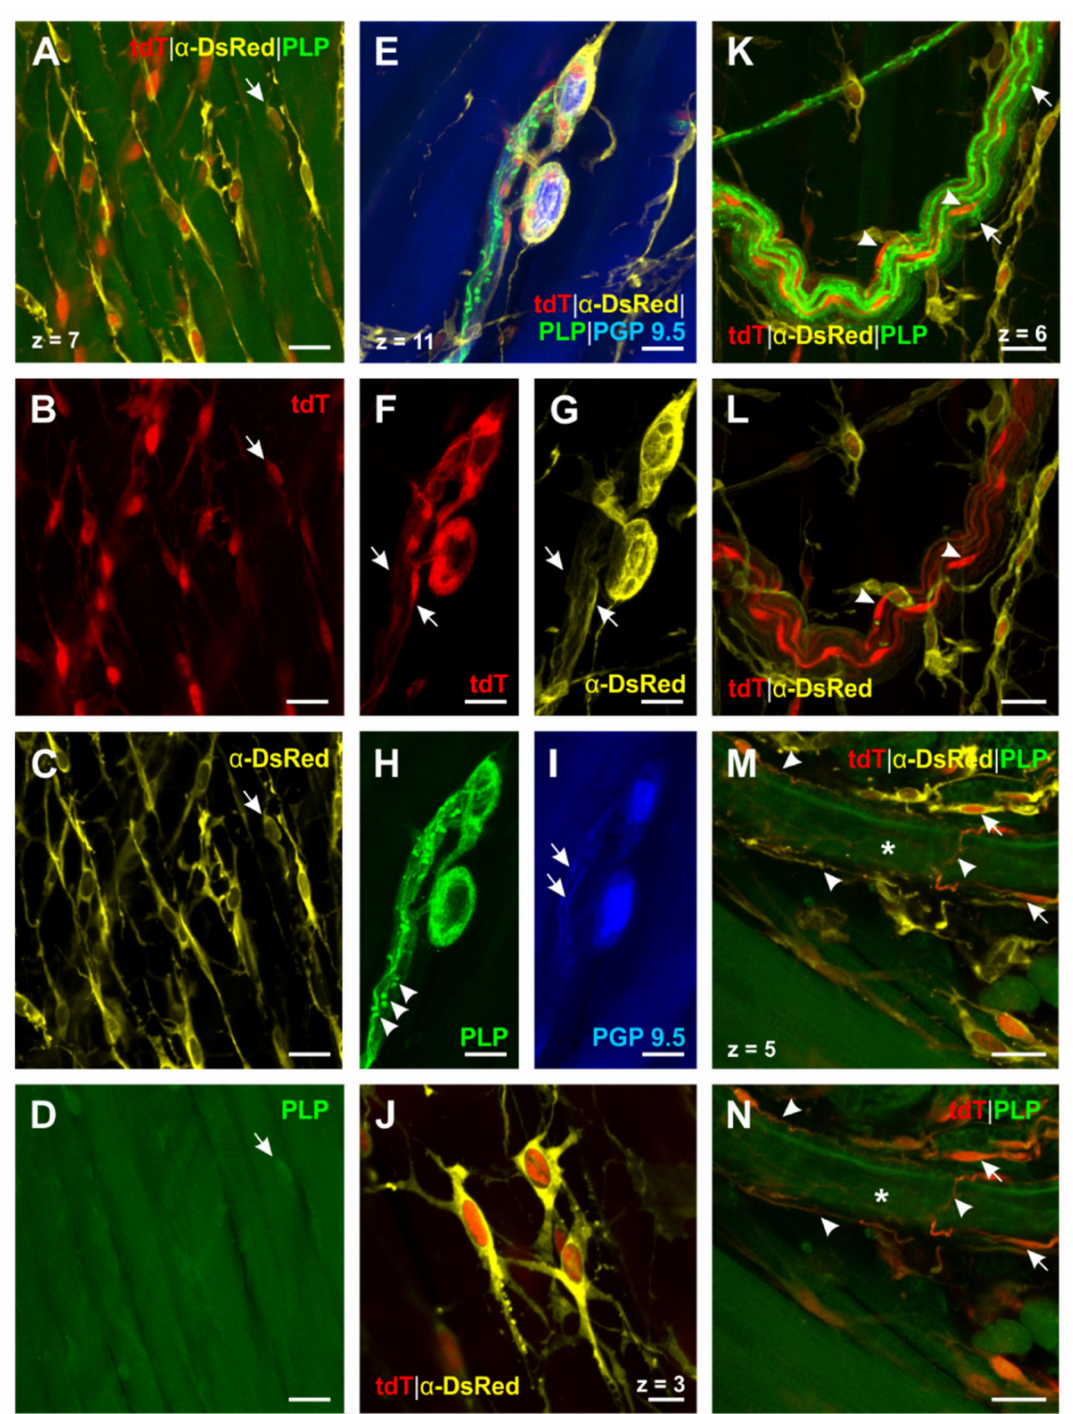
Figure 4. PLP + -glial cells in the esophagus identified by triple staining for DsRed, PLP and PGP 9.5 in PLP-CreERT2 x tdT mice (N ◦ 2 (cid:13) , Table 2). ( A )–( D ) (PGP 9.5 not shown): PLP + -glial cells form a meshwork throughout the esophagus. Some